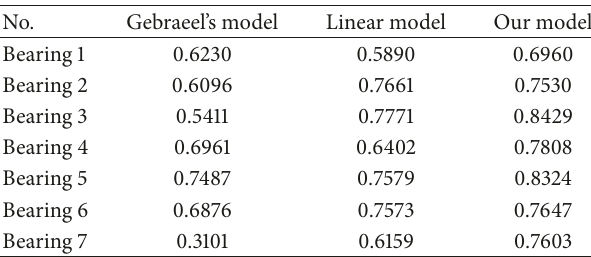
Table 6: CRA for tested